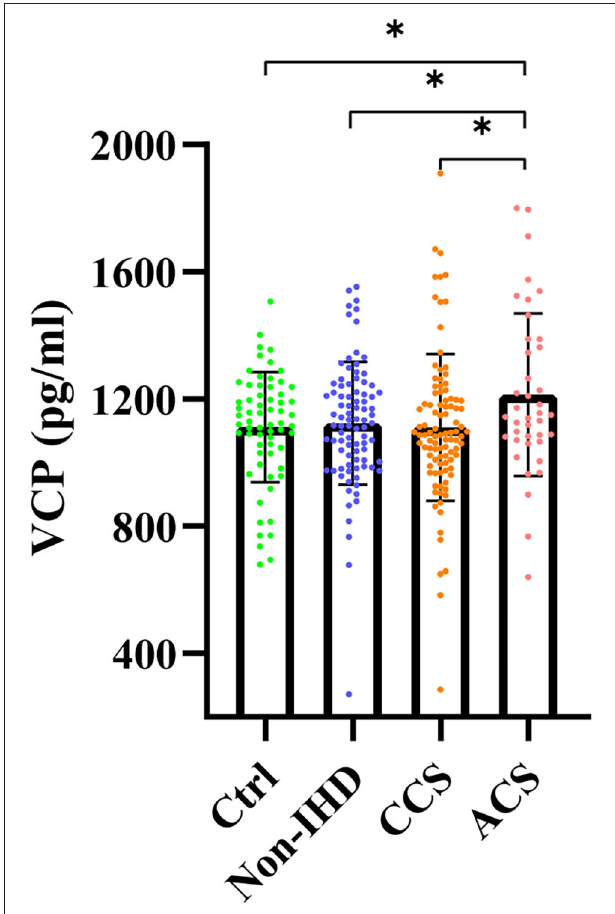
FIGURE 1 | Serum VCP levels of healthy control group (Ctrl), nonischemic heart disease group (non-IHD), chronic coronary syndrome group (CCS), and acute coronary syndrome group (ACS) (* p < 0.05).